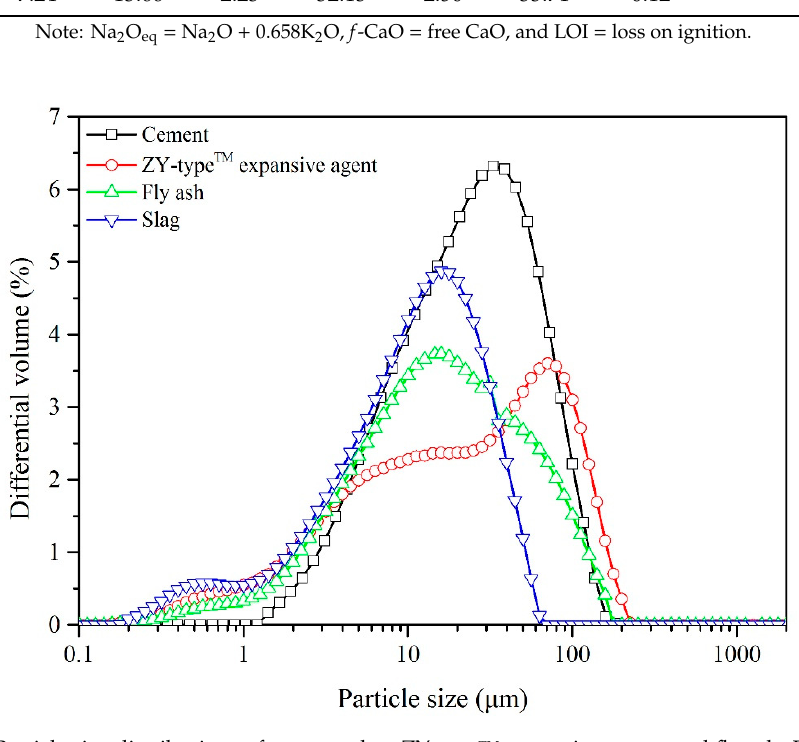
Figure 1. Particle size distributions of cement, slag, ZY-type ™ expansive agent, and fly ash. D 50 values (the particle size corresponding to 50% cumulative particle size distribution): cement, 22.11 µ m; slag, 11.24 µ m; ZY-type ™ expansive agent, 22.44 µ m; fly ash, 15.89 µ m. Table 2. Mix proportions of pastes Table 1. Chemical compositions of cement, fly ash, slag, and ZY-type TM expansive agent (wt.%).